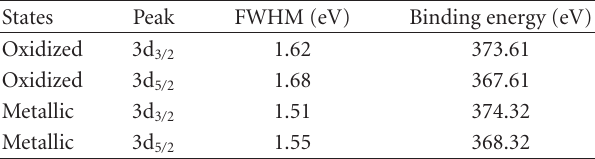
Table 1: The variations of FWHM and binding energy shifts of metallic silver and oxidized silver of Ag3d 3 / 2 and Ag3d 5 / 2 .